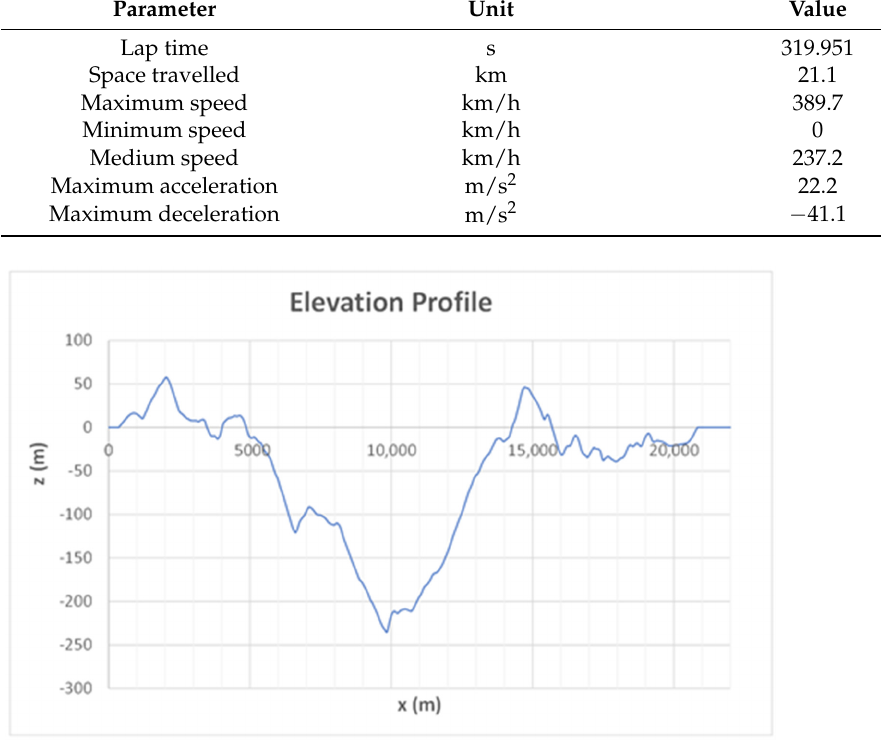
Figure 16. Elevation profile of the Nordschleife circuit. In particular, the graph shows the elevation vs. the “longitudinal” position of the hypercar on the track (the space travelled by the hypercar on the Nordschleife circuit).